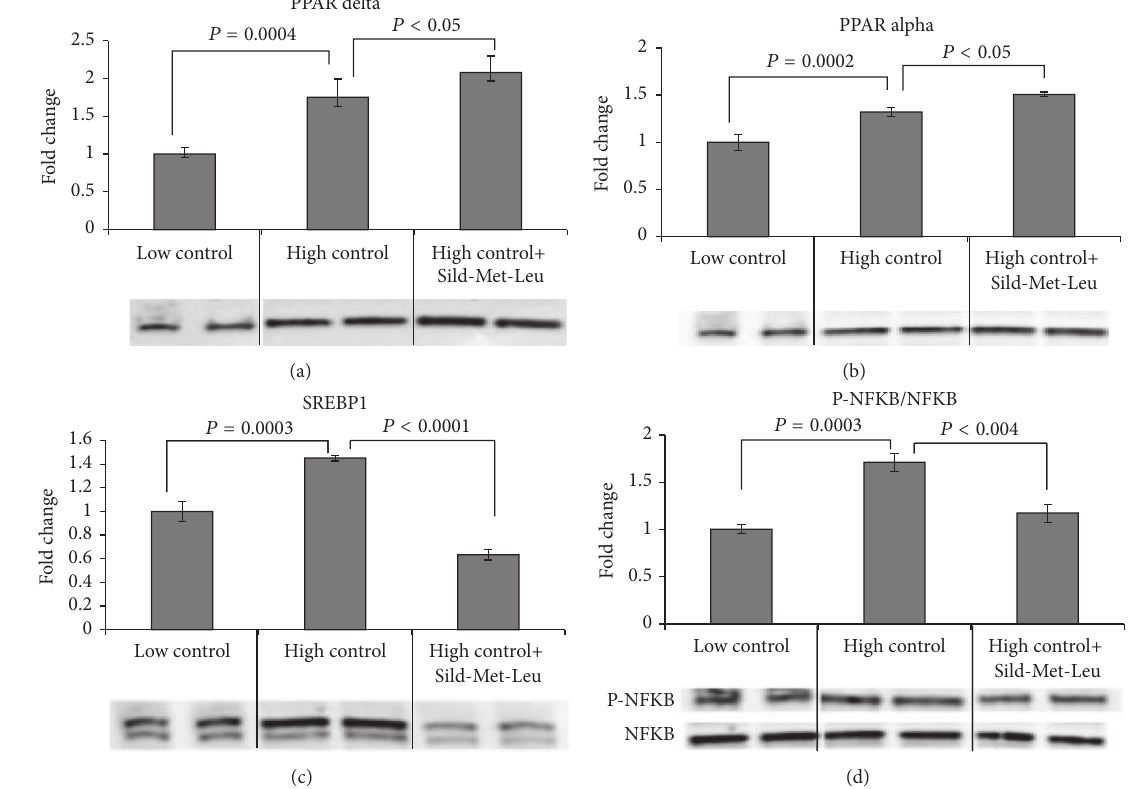
Figure 3: Sild-Met-Leu treatment in hepatocytes increases PPAR alpha and delta and decreases SREBP1 and NF- 𝜅 B. HepG2 cells were treated with sildenafil (Sild, 1nM), metformin (Met, 0.1mM), and leucine (Leu, 0.5 mM) as indicated for 24 hours after induction of lipid accumulation and compared to nontreated cells after lipid accumulation (high control) or without lipid accumulation (low control). Protein expression of (a) PPAR delta, (b) PPAR alpha, (c) sterol regulatory element-binding protein (SREBP) 1, and (d) ratio of phosphorylated to total NF- 𝜅 B was measured. Quantitative data are presented as mean ± SEM ( 𝑛 = 4 ) and representative blots are